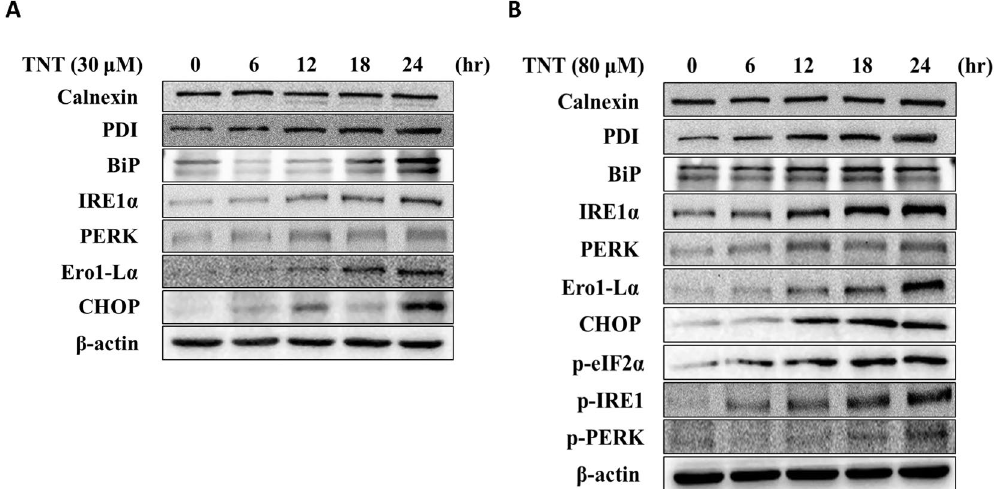
Figure 2. TNT-induced ER stress in HepG2 cells. The effects of ( A ) 30 μ M TNT and ( B ) 80 μ M TNT on the expression of ER stress related proteins. HepG2cells were treated with TNT at the indicated concentrations for 0, 6, 12, 18, and 24 h. Whole-cell lysates were obtained and subjected to Western blot analysis using antibodies against calnexin, PDI, BIP, IRE1- α , PERK, Ero1-L α , CHOP, phosphorylated eIF2 α , phosphorylated IRE1, phosphorylated PERK and β -actin. The bands were excised from different gels that were run under the same electrophoresis